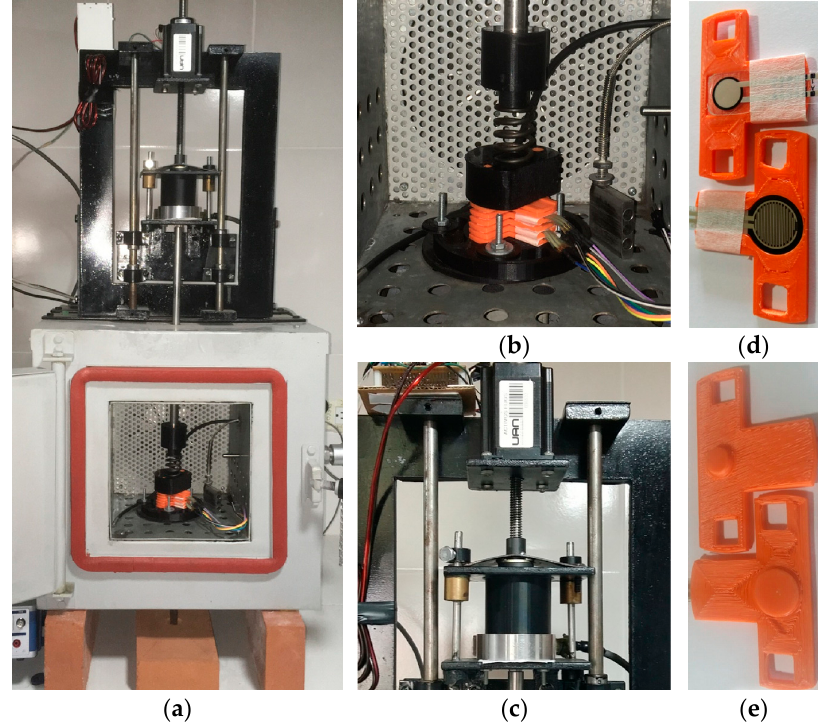
Figure 9. Mechanical setup for gathering sensor data. ( a ) Overview of the testbench; ( b ) Zoom-in picture depicting the sensors location inside the chamber and the spring for mechanical compliance; ( c ) Zoom-in picture showing the linear stepper motor and the LCHD-5 load cell, manufactured by Omega Engineering (Norwalk, CT, USA); ( d ) Top and ( e ) bottom views of the custom-made sensor holders and pucks, respectively; Sensors are harnessed using paper tape as in ( d ).